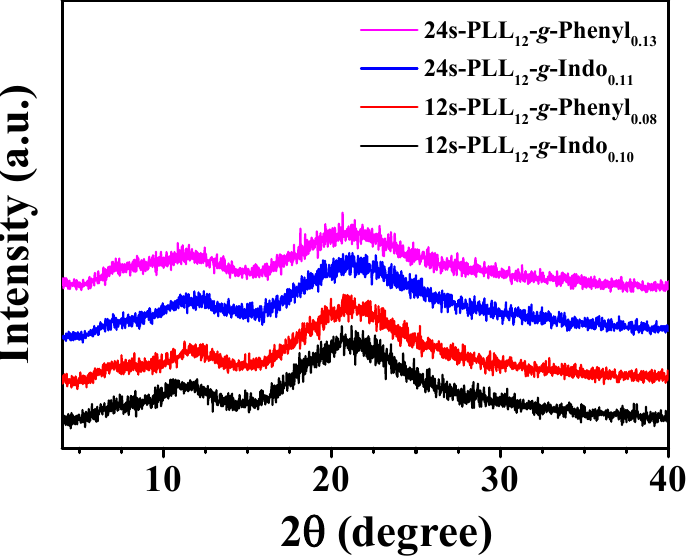
Figure 3. XRD patterns of 12-armed and 24-armed graft polypeptides. All the samples were lyophilized before analyzing. The concentration of 12-armed and 24-armed polypeptide hydrogels were 8.0 wt% and 5.0 wt%, respectively.